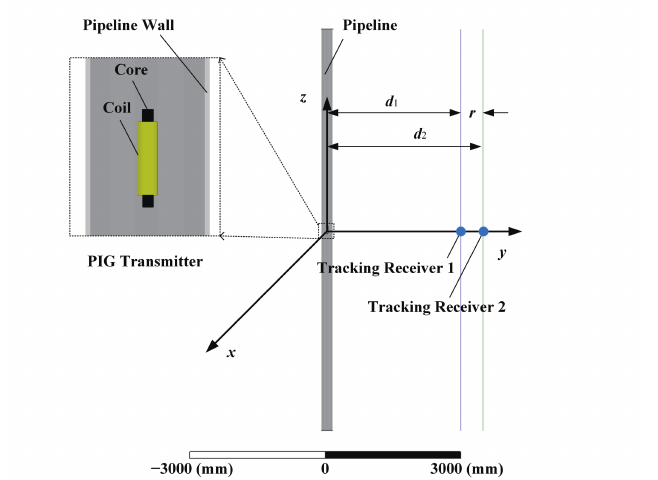
Figure 5. The 3-D FEM model of the dual tracking system. The gray cylinder represents the pipeline, the yellow one represents the transmitting coil, the black one represents the magnetic core and the dual blue points represent the dual tracking